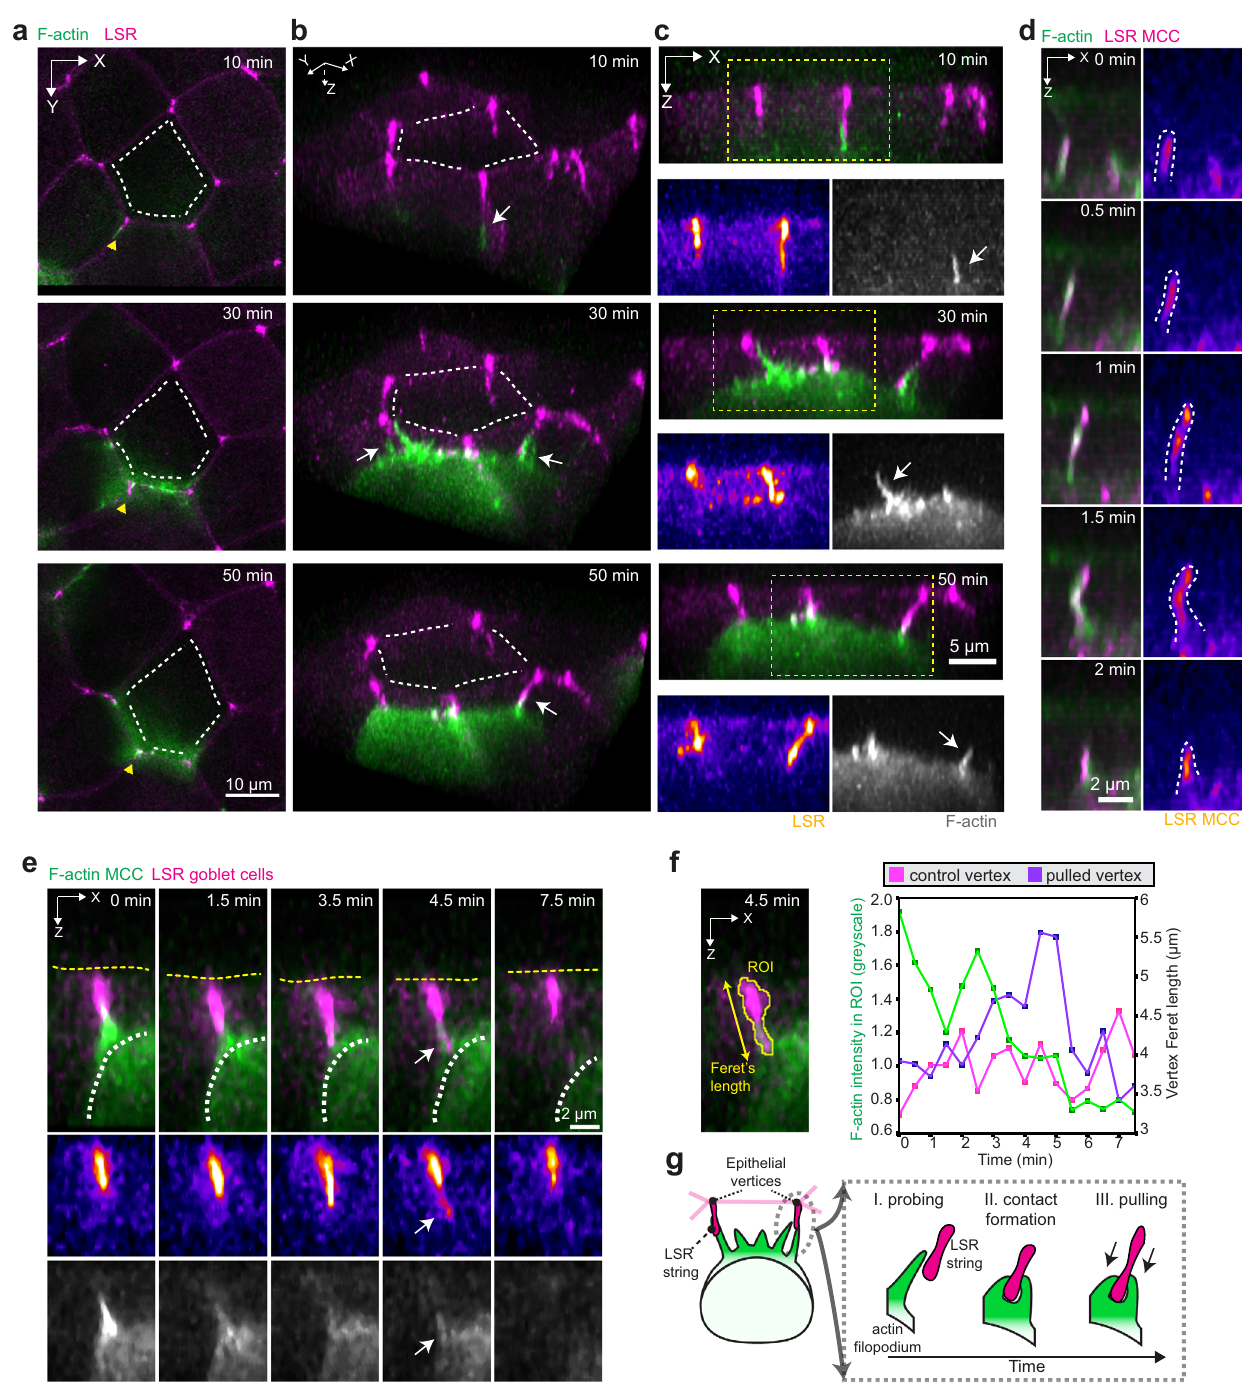
Fig. 2 | Integrating MCCs pull on the epithelial vertices. a – d Filopodia interact with epithelial vertices as MCC moves into the super fi cial epithelium. The actin cortex of MCCs is labeled with α -tubulin::LifeAct-RFP (pseudo-colored in green in compositeimagesandgrayasaseparatechannel). a Imagesequenceofintegrating MCCinteractingwithoverlyingvertices.Epithelialverticesarelabeledwithlipolysis stimulated lipoprotein receptor tagged with x3GFP (LSR, pseudo-colored in magenta in composite images and fi re as a separate channel). Scale bar: 10 μ m. White dotted lines outline overlying junctions. The yellow arrowheads depict the orientation used for 3D rendering in b . b 3D rendering of a , with MCC forming contacts with different vertices (marked by white arrows). White lines outline overlying junctions. c Orthogonal ( XZ ) projections of a , depicting the attachment between fi lopodia(markedbywhitearrows)andvertices.Yellowboxesmarkinsets